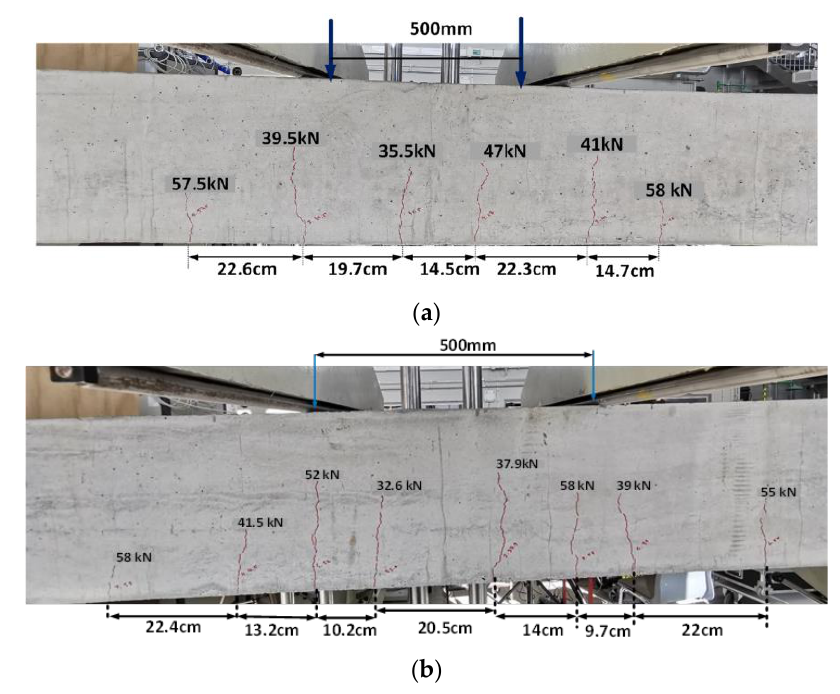
Figure 6. ( a ) Beam A.50 (50% of Py). ( b ). Beam B.50 (50% of Py). Beam A.70 (from Batch A) and Beam B.70 (from Batch B) were preloaded to 81.2 kN (70% of Py (81.2 kN)). Figure 7a shows the flexural cracks observed in Beam B.70. Between nine and eleven cracks were visually observed in beam A.70 and B.70, respectively. Within the constant bending zone, four to five flexural cracks were observed in both beams. Four to five flexural-shear cracks appeared in the constant bending zone. Within the constant bending zone, there was no significant difference the maximum crack spacing of A.70 and B.70 (see Figure 7a,b), within the constant bending zone. ( a ) ( b ) Figure 7. ( a ) Beam B.70 (70% of Py). ( b ). Beam A.70 (70% of Py).